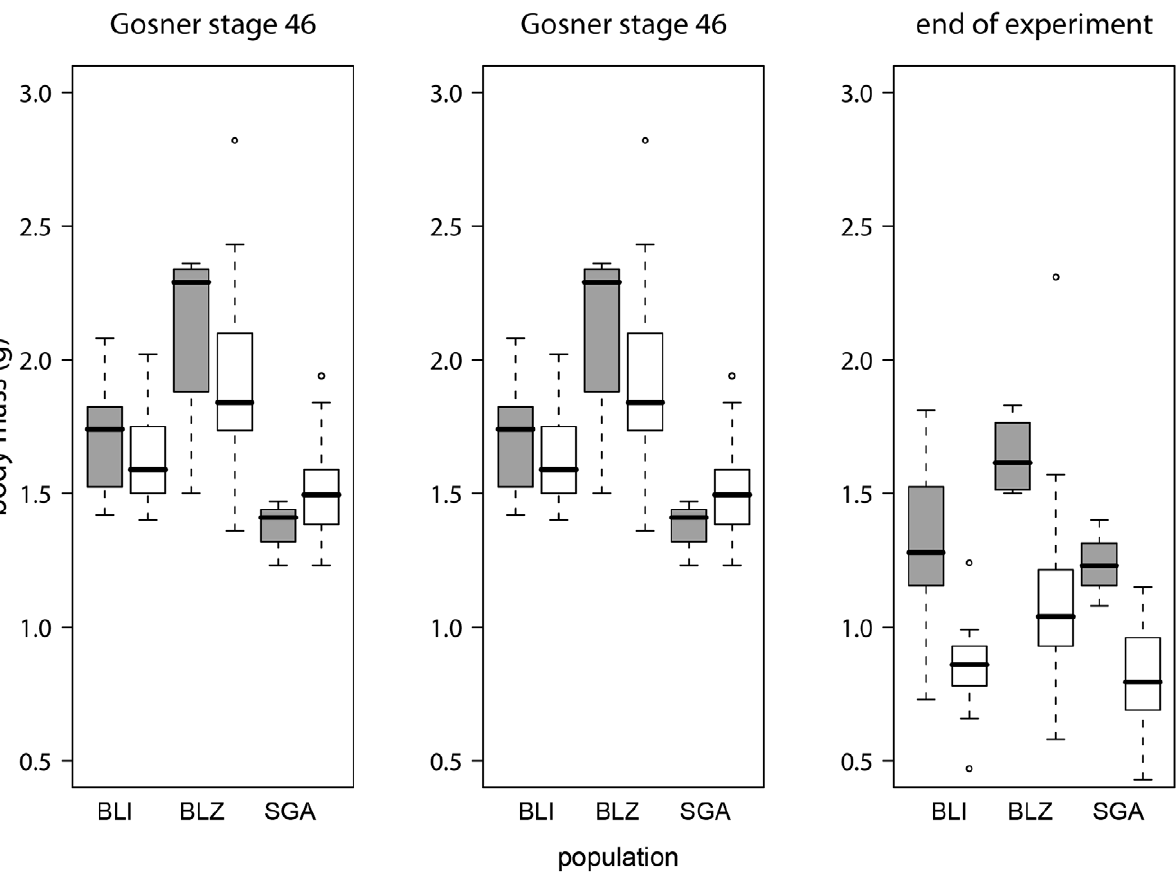
Figure 3. Body mass in surviving and non-surviving individuals. Boxplots showing body mass of infected individuals at the beginning of metamorphosis (Gosner stage 42), at the end of metamorphosis (Gosner stage 46) and at the end of the experiment or death. Grey boxes=survivors, white boxes=non-survivors. The black line represents the median, the box represents the interquartile range containing 50% of the values, and whiskers mark the 1.5 fold interquartile range. Outliers are marked with circles. Grey boxes=survivors, white boxes=non-survivors.